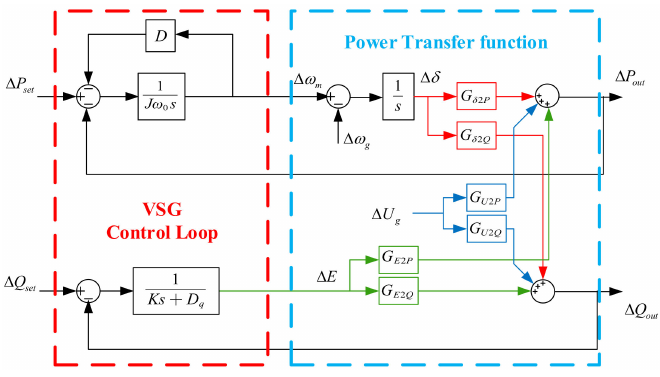
Figure 3. Accurate small-signal model of VSG.